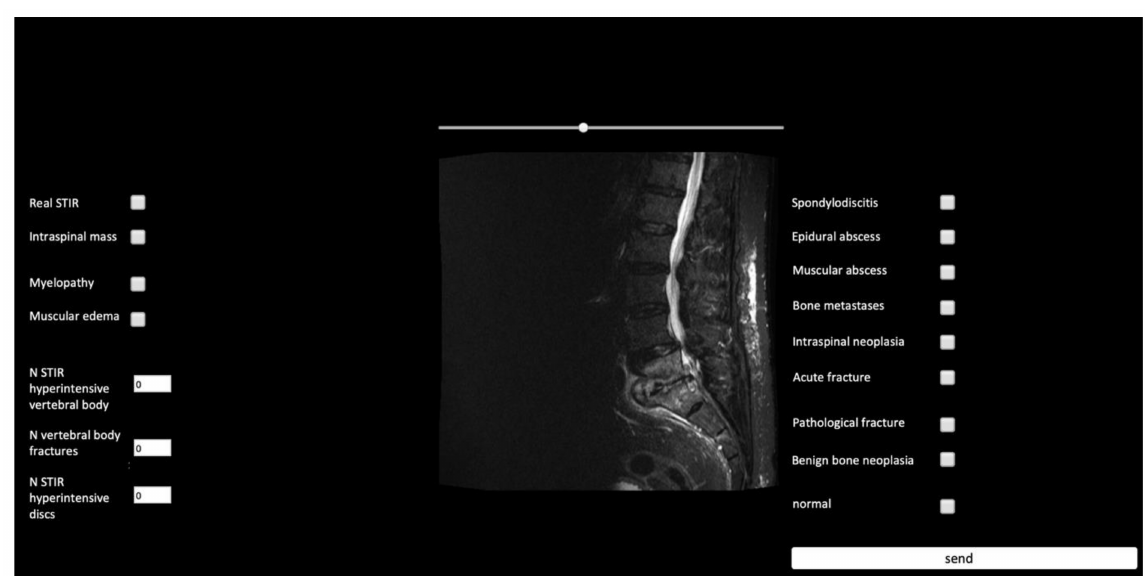
Figure 2. Structured reporting using our web tool developed